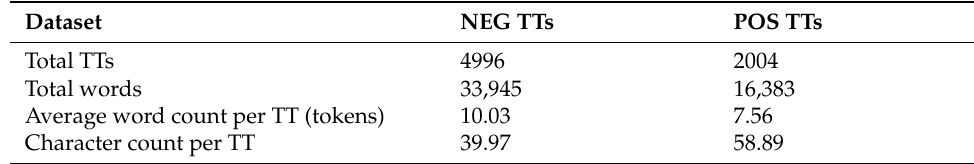
Table 2. Data retrieved from our collection of